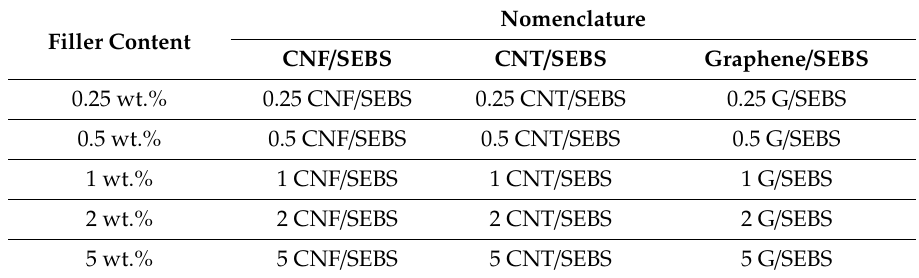
Table 1. Nomenclature of the SEBS composites with different nanocarbonaceous fillers and